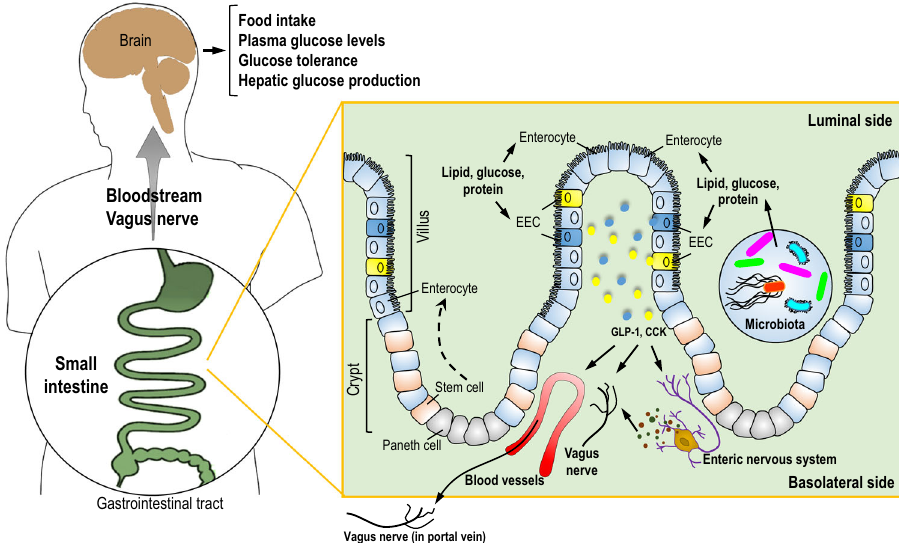
Fig. 1 An integrated hormonal-dependent metabolic network that is activated by small intestinal nutrient sensing. Glucose, lipids, and protein from ingested foods are taken up by small intestinal enterocytes for cellular metabolism and absorption. Preabsorptive nutrients also activate enteroendocrine cells, triggering the release of GLP-1 and CCK. CCK and GLP-1 enter the circulation and act directly on peripheral organs to regulate metabolism. In parallel, CCK and GLP-1 act on the vagus nerve innervating the small intestine or portal vein as well as interact with the enteric nervous system to regulate glucose and energy homeostasis. In this context, the central nervous system can receive neuronal and/or direct hormonal signals to regulate feeding and maintain plasma glucose